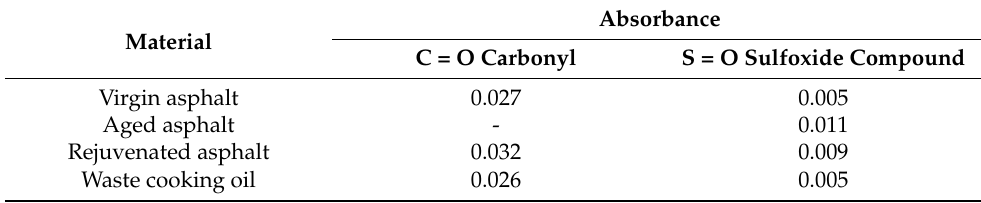
Table 18. Absorbance of key functional group [58].